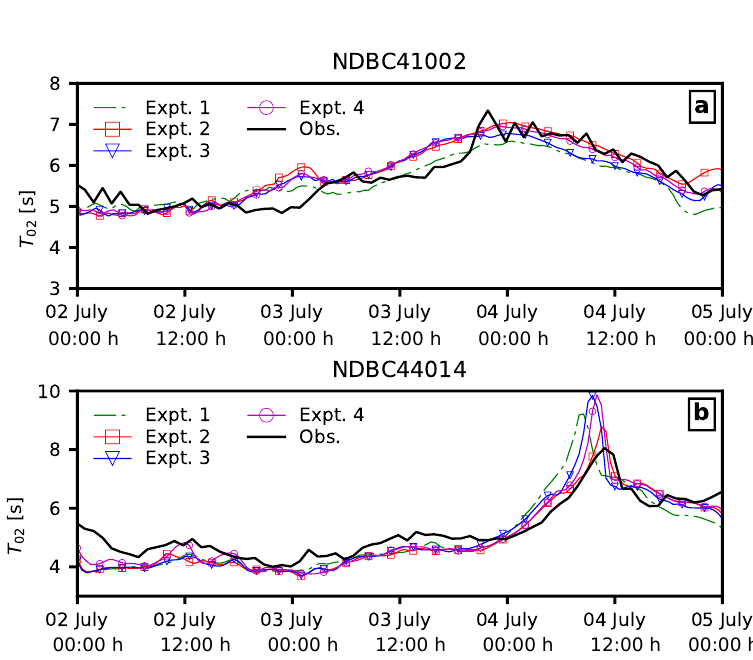
Figure 10. As in Fig. 7, but for wave period T 02